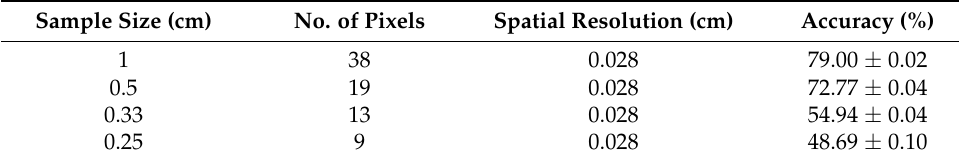
Figure 5. Accuracy of chemical at different altitude of sensors. Table 1. Determines the accuracy of chemical at different height of sensors.